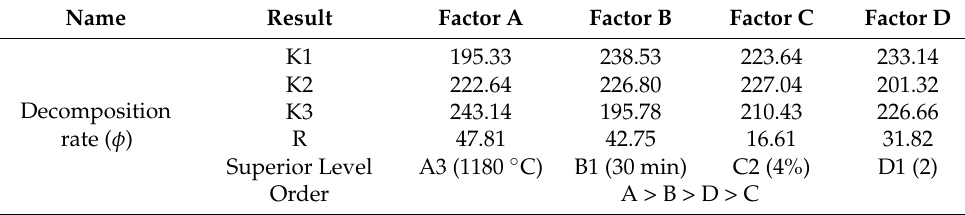
Table 6. Range analysis of orthogonal